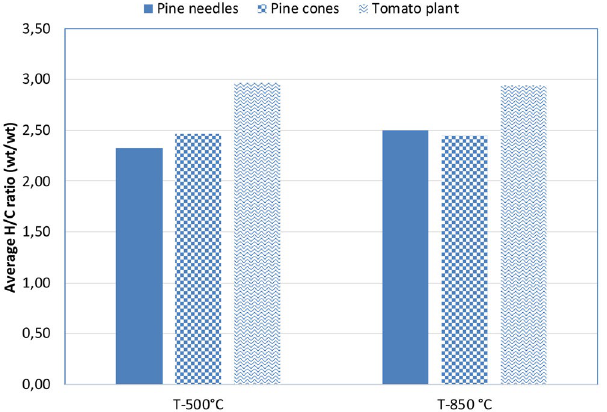
Figure 5. Evolution of the average H/C ratio in biomass feedstock decomposition at temperatures with λ C close to